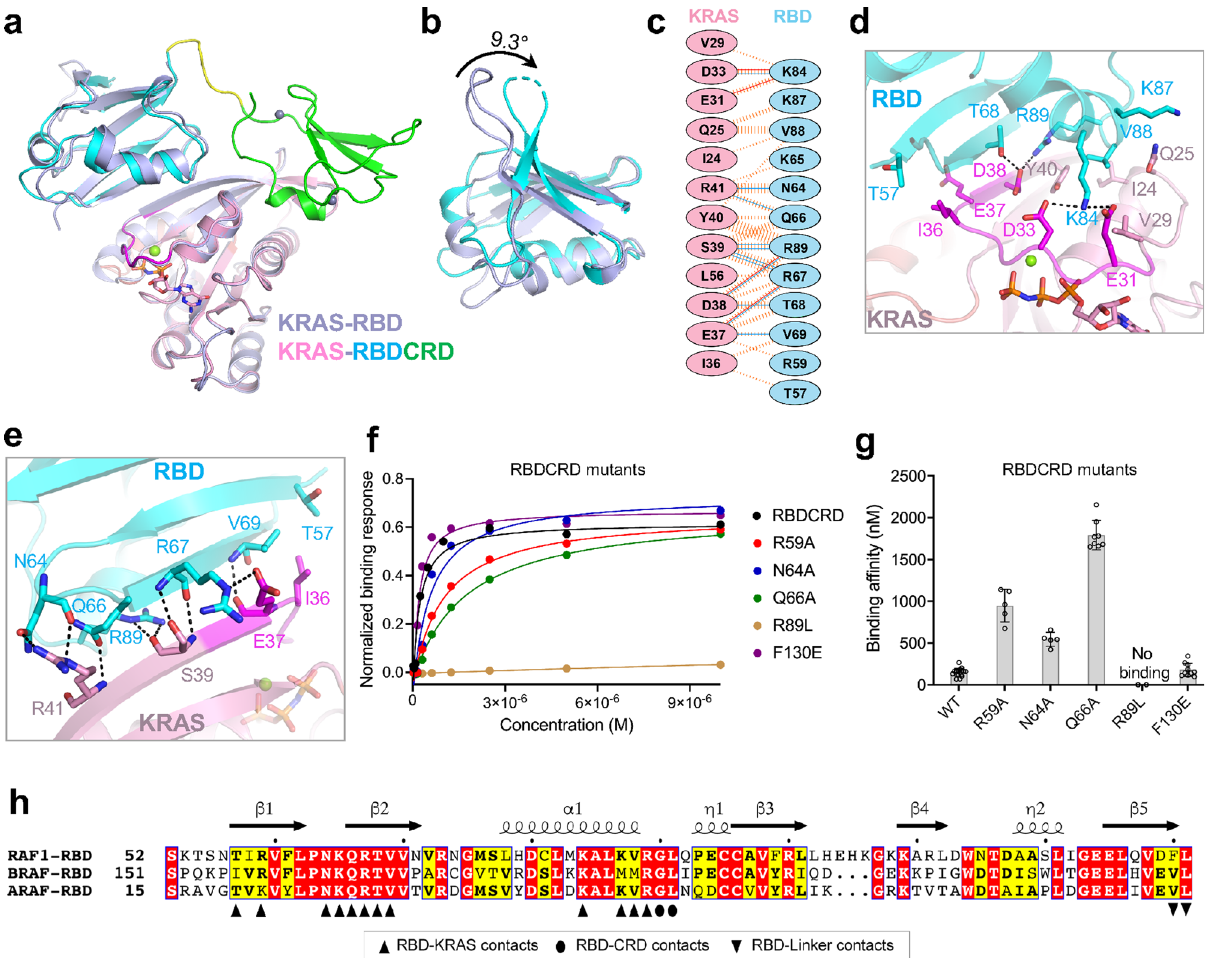
Fig. 2 Structural and mutational analyses of the KRAS-RBD interactions in the KRAS-RBDCRD complex. a Superposition of KRAS-RBD structure (light blue) with KRAS-RBDCRD structure shows conformational differences in RBD. The structural superposition was carried out by aligning atoms in KRAS in both structures. b Enlarged view of RBD showing conformational differences that occur when it binds to KRAS as RBD vs. RBDCRD. c Schematic representation of the KRAS-RBD interaction interface, as identi fi ed by PDBSum (http://www.ebi.ac.uk/pdbsum/). The interactions are colored using the following notations: hydrogen bonds — solid blue lines, salt bridges — solid red lines, non-bonded contacts — striped orange lines (width of the striped line is proportional to the number of atomic contacts). d , e Enlarged view of the KRAS-RBD interaction interface formed by residues present in the d switch-I region (magenta), and e β 2 strand (residues present at the end of the switch-I region) of KRAS. The nucleotide GMPPNP and residues that participate in the protein – protein interaction are shown in stick representation. Dashed black lines indicate intermolecular hydrogen bonds and salt bridges. f Steady- state binding isotherms derived from the SPR data for different point mutants of RBDCRD binding to KRAS-GMPPNP. g A bar graph showing binding af fi nity ( K D ) obtained using the SPR data shown in f for point mutants of RBDCRD located at the KRAS-RBD interface. The K D values are reported as the mean ± standard deviation from multiple replicates; WT ( n = 17), R59A ( n = 5), N64A ( n = 5), Q66A ( n = 8), R89L ( n = 4), and F130E ( n = 10). Source data are provided as a Source Data fi le. h Amino acid sequence alignment of residues present in the RAS-binding domain (RBD) of human RAF1, BRAF, and ARAF. Fully and partially conserved residues among the RAF isoforms are highlighted in red and yellow, respectively. The secondary structure of RAF1 (RBD) is shown above the alignment. The RBD residues that are involved in the interaction with KRAS, CRD, and the linker region are indicated below the alignment with upright triangles, ovals and inverted triangles,